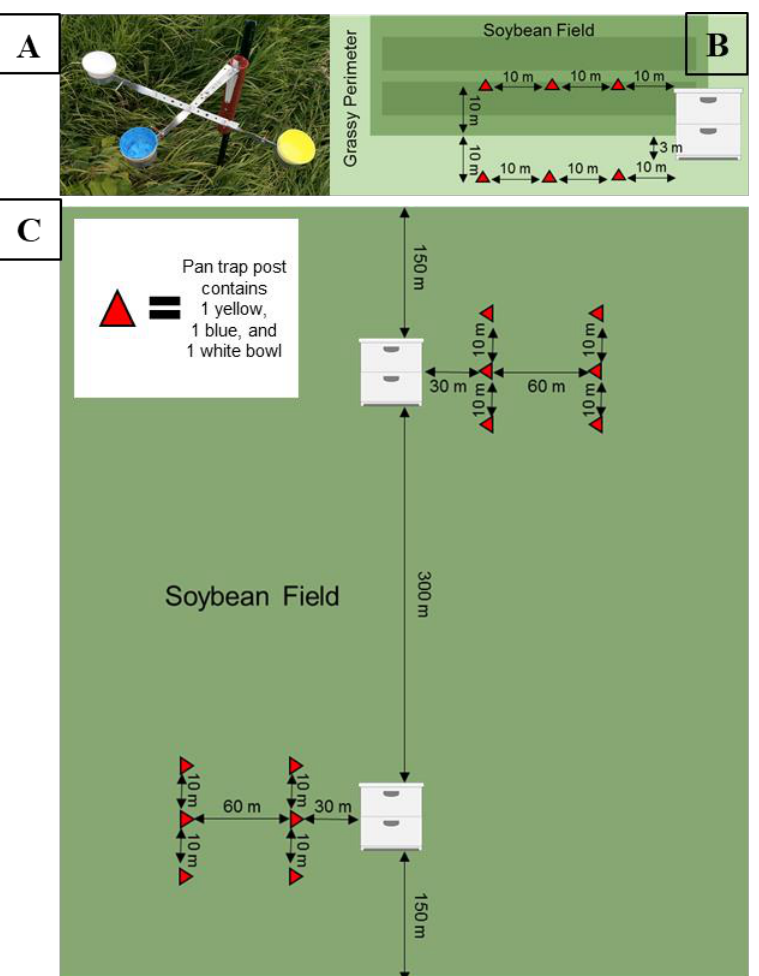
Figure 1. ( A ) Pan trap design for a single post constructed to hold three 3.2 oz bowls painted fluorescent yellow, fluorescent blue, or left white. ( B ) Experimental design of soybean fields in 2015 and 2016 (experiment one). Four colonies were placed 3 m from the field edge. In 2015, three posts were placed in the interior of the field adjacent to the colonies. In 2016, three posts were placed in the interior and the exterior of the field adjacent to the colonies. ( C ) Experimental design for soybean fields in 2017 and 2018 (experiment two). An apiary of 16 colonies was placed inside the fields (8 at each sub-site). In August, half of the colonies were removed from each sub-site, resulting in 4 colonies per sub-site remaining. Pan trap posts were placed 30 m and 90 m from the colonies at each sub-site.